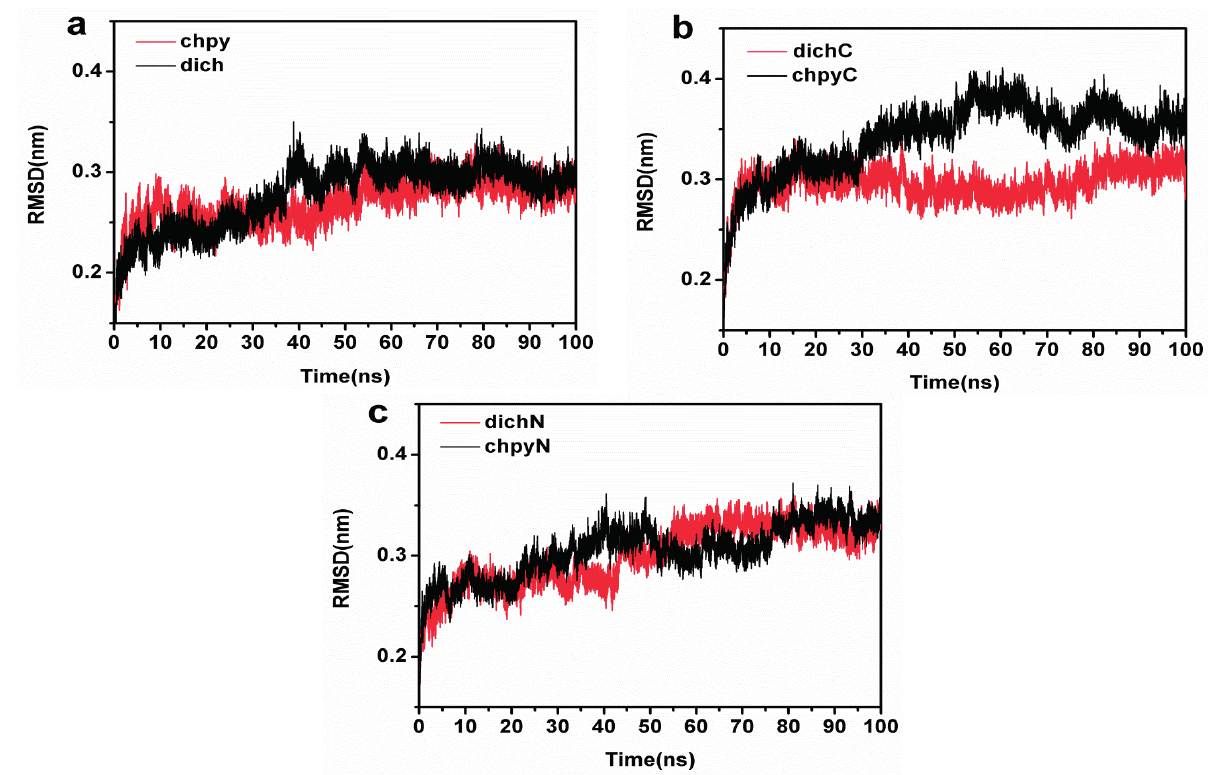
Figure 6. ( a ) Root-mean-square deviation (RMSD) plot of chlorpyrifosmethyl oxon (red) and dichlorvos (black) during 100 ns molecular dynamics (MD); ( b ) RMSD plot of α / β hydrolase domain (residues 8–23, 325–581) of chlorpyrifosmethyl oxon (black) and dichlorvos (red); and ( c ) RMSD plot of β -propeller domain (residues 24–324) of chlorpyrifosmethyl oxon (black) and dichlorvos